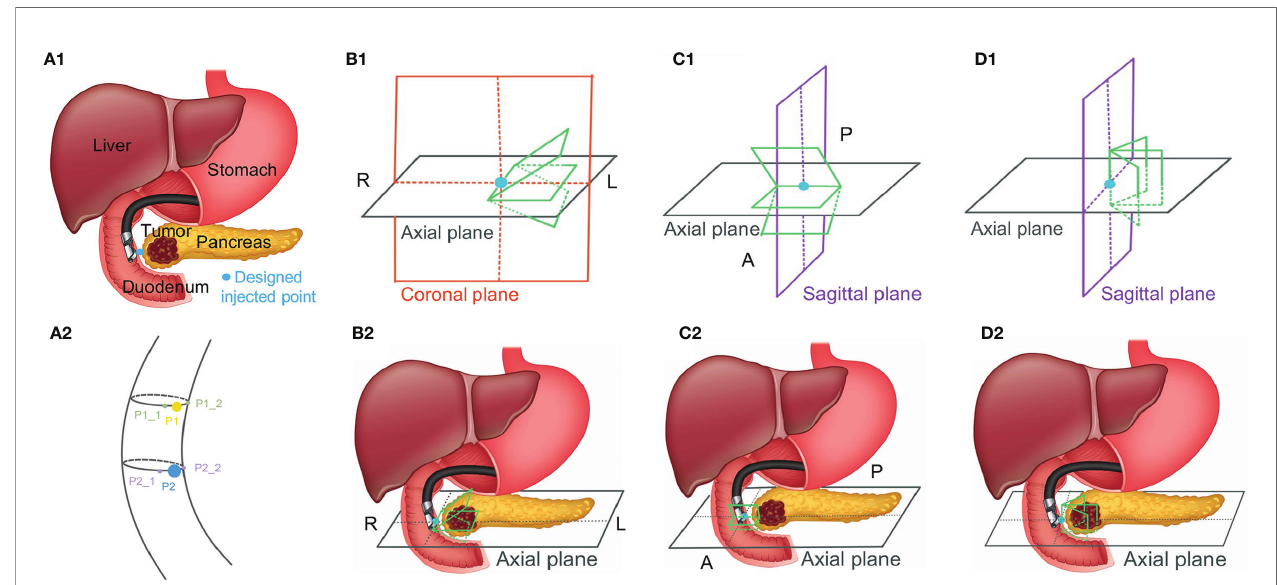
FIGURE 5 | The simulated injected point and interpolation of MRI image. R, L, P, and A represent right, left, posterior, and anterior,